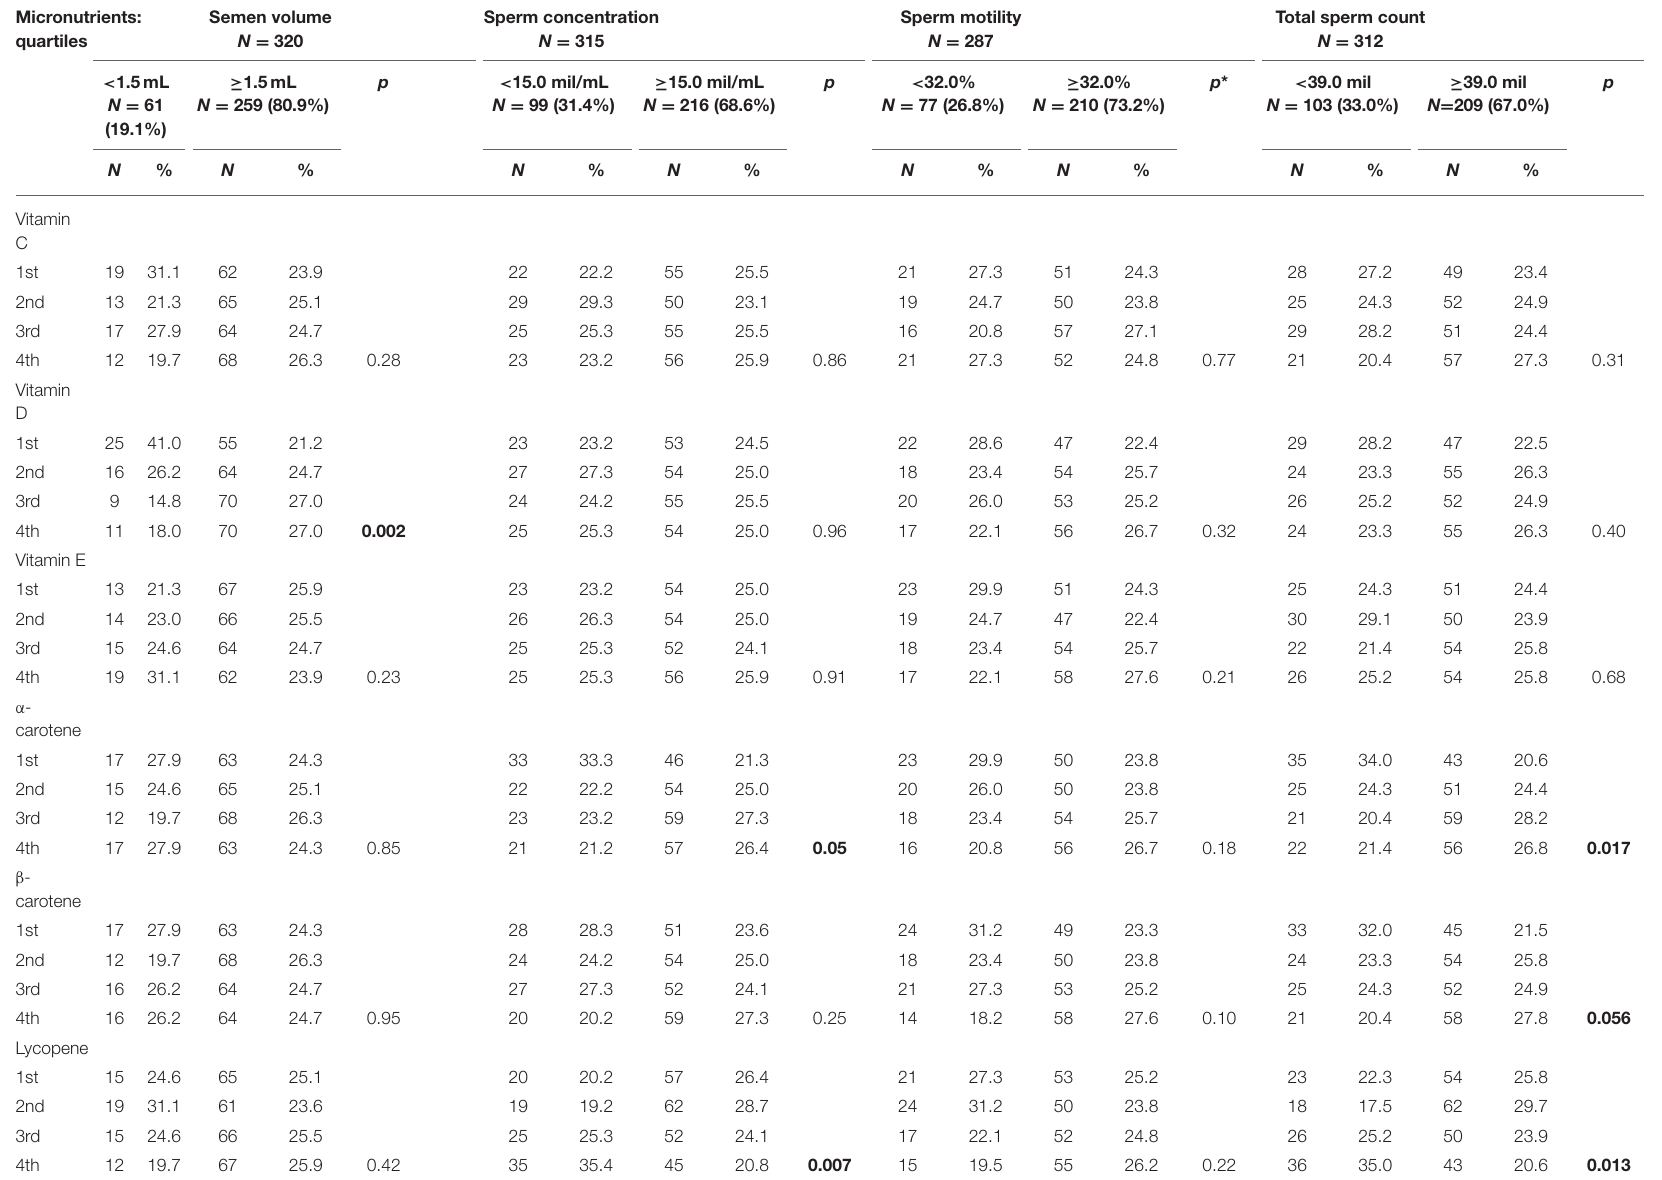
TABLE 1 | Antioxidants and micronutrients intake of 323 men undergoing assisted reproduction technique, according to presence of sperm abnormalities. Micronutrients: